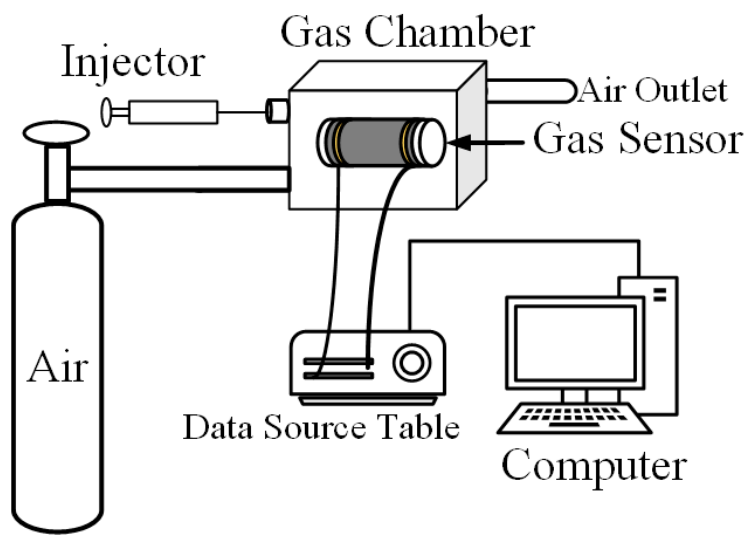
Figure 2. Gas sensing test system.